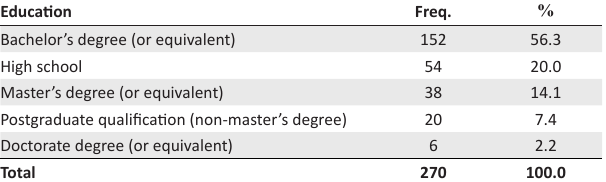
TABLE 1c: Background of respondents.